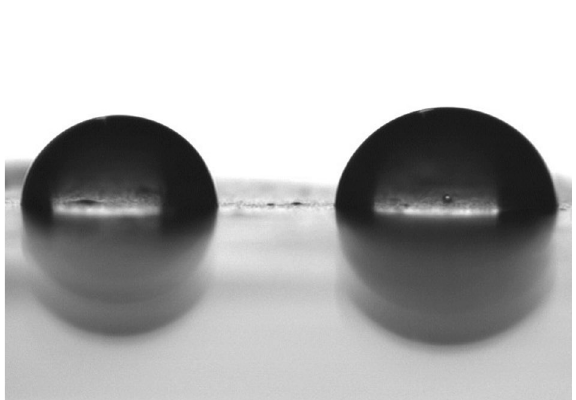
Figure 2. Hydrophobic behaviour of the PP film showing a high contact angle (97.8° ± 1.1°) of a drop of PBS (left) and a lower contact angle (86.4° ± 1.1°) of a drop of PBS with 5% glycerol (right) (p < 0.001) measured with a SURFTENS universal goniometer. The white rectangle inside the droplets is the reflections of the diffuse light illuminating the drop to obtain the image with a sharper